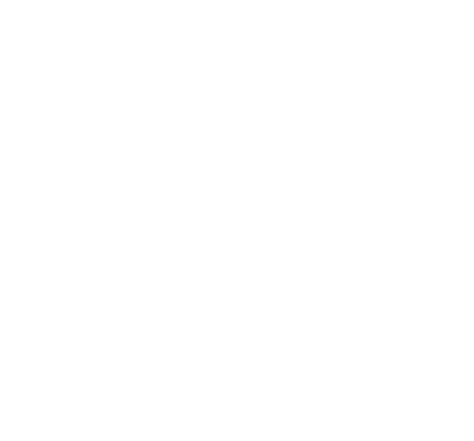
Figure 1. Shear test as per ASTM-D2344. Force and deflection for all tested samples were recorded, and diagrams similar to Figure 2 were attained.